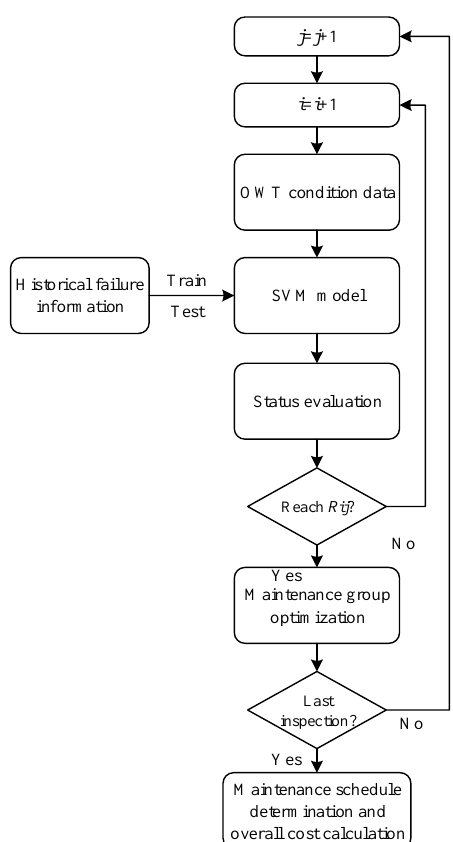
Figure 3. Flow diagram of OWT Opportunistic condition-based maintenance (CBM) optimization.